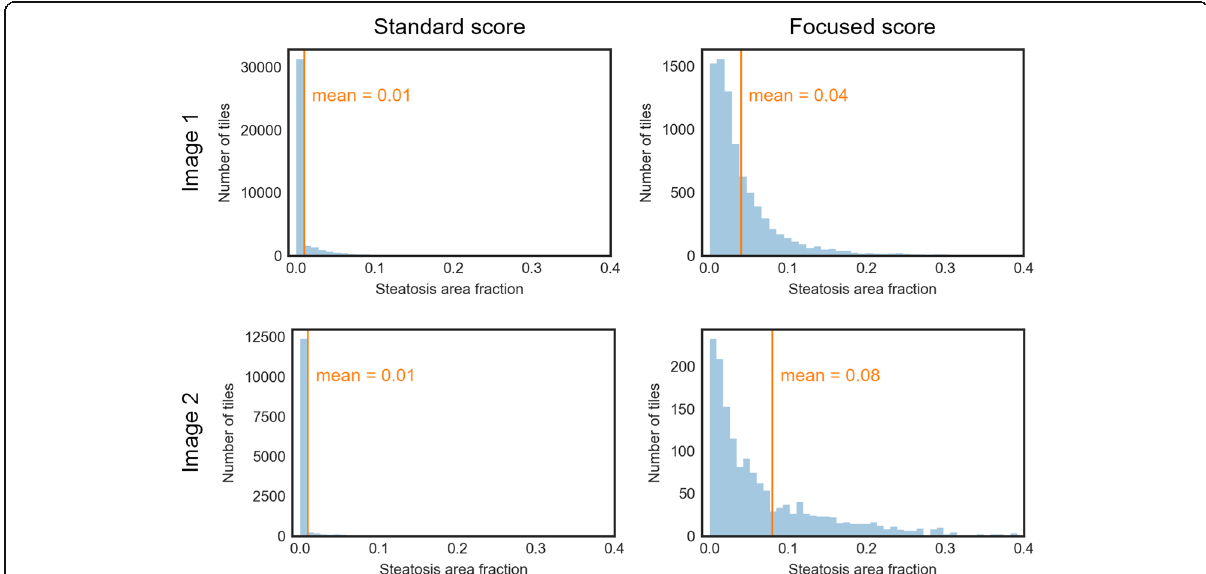
Fig. 4 Score computation. The plots show distributions of tile-based steatotic area fractions of two example images. The columns illustrate the computation of the standard score and a mean-based focused score, respectively. While all tiles are considered for the standard score, only steatotic tiles are considered for the focused score. The large peak at value 0 makes the standard scores of both images